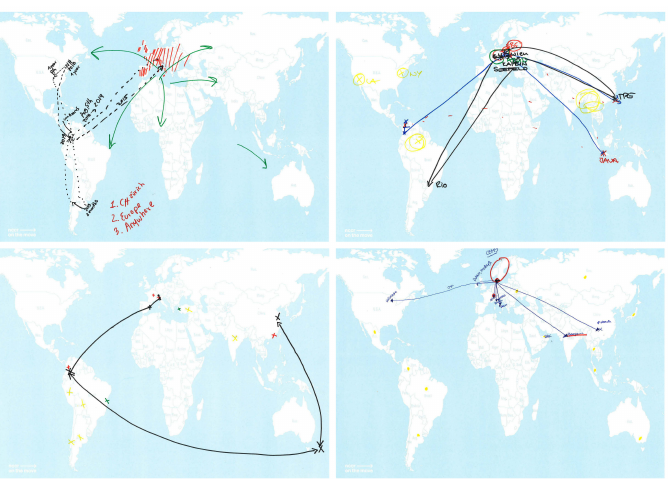
Figure 1. Drawings of research participants’ mobility trajectories on geographical maps in Switzerland.